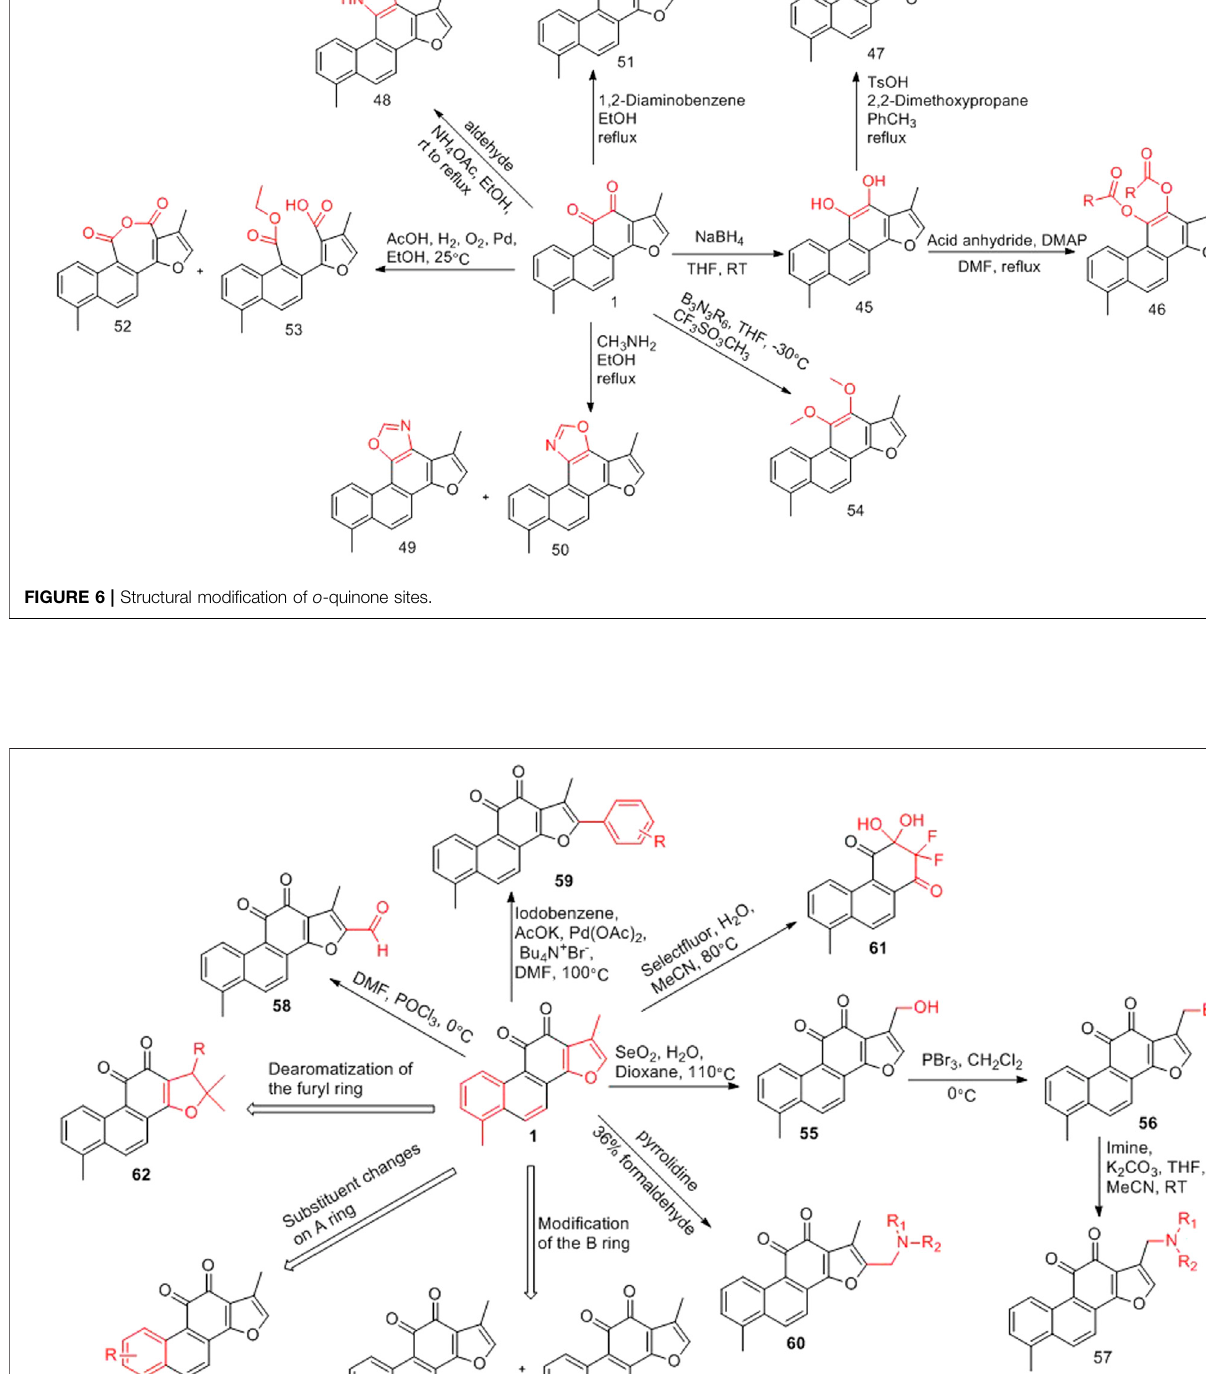
Frontiers in Pharmacology |